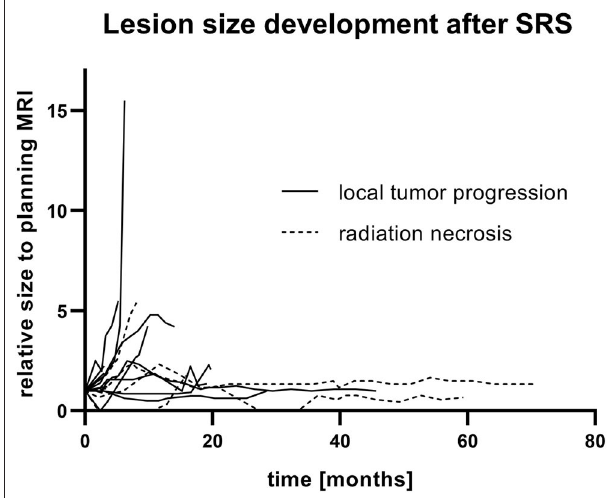
FIGURE 3 | Lesion size development after single-fraction stereotactic radiosurgery (SRS) and concurrent immunotherapy of all reliable diagnoses of local tumor progression and CNS radiation necrosis. Relative change of the biggest diameter in the contrast-enhanced T1-weighted sequence of follow-up MRI to the corresponding planning MRI is